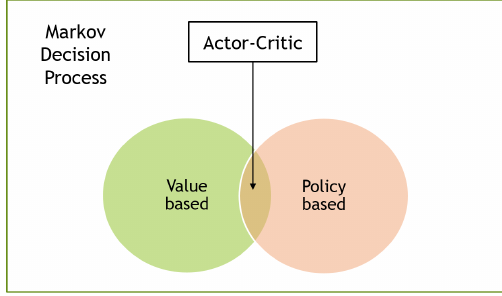
Figure 3. Types of RL